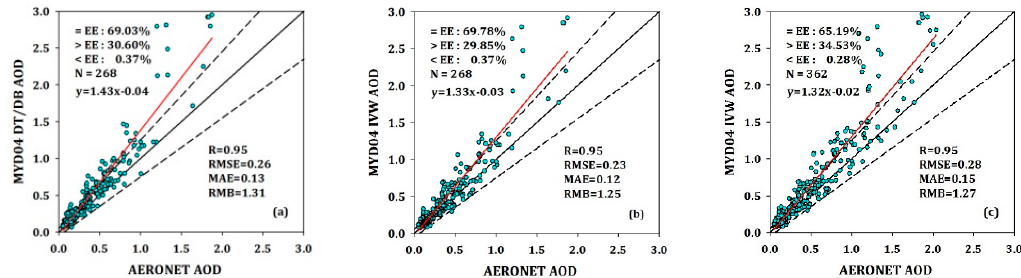
Figure 4. Scatterplots and statistical parameters of dark target (DT) and deep blue (DB) aerosol optical depth (AOD) ( a ), Method I ( b ), and Method II ( c ). The dashed lines represent the expected error (EE), the black solid line represents the 1:1 line, and the red line represents the fitted linear regression line.